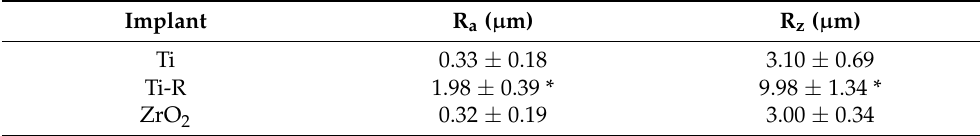
Table 2. Roughness for each dental implant